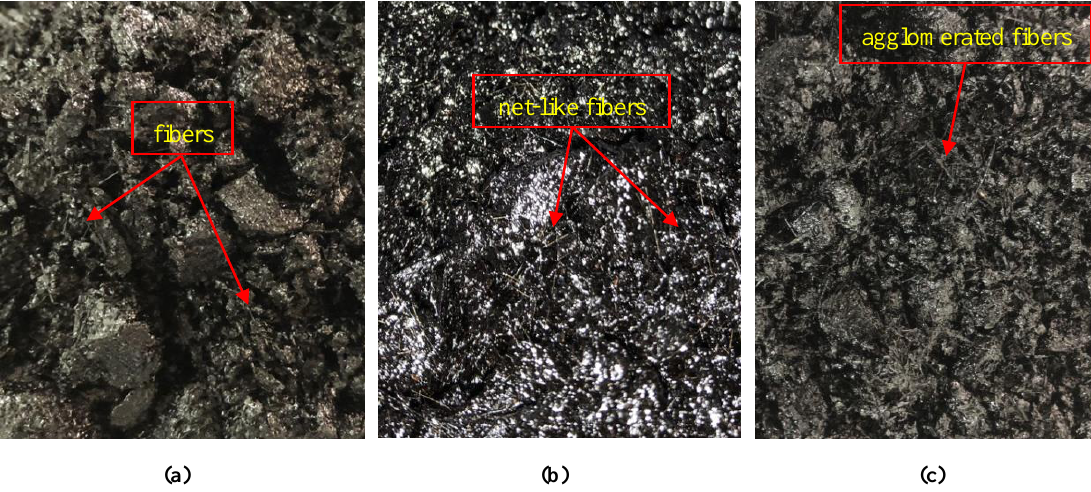
Figure 8. Distribution pattern of the fiber in the asphalt mixture. ( a ) 0.15% fiber content; ( b ) 0.3% fiber content; and ( c ) 0.45% fiber content.